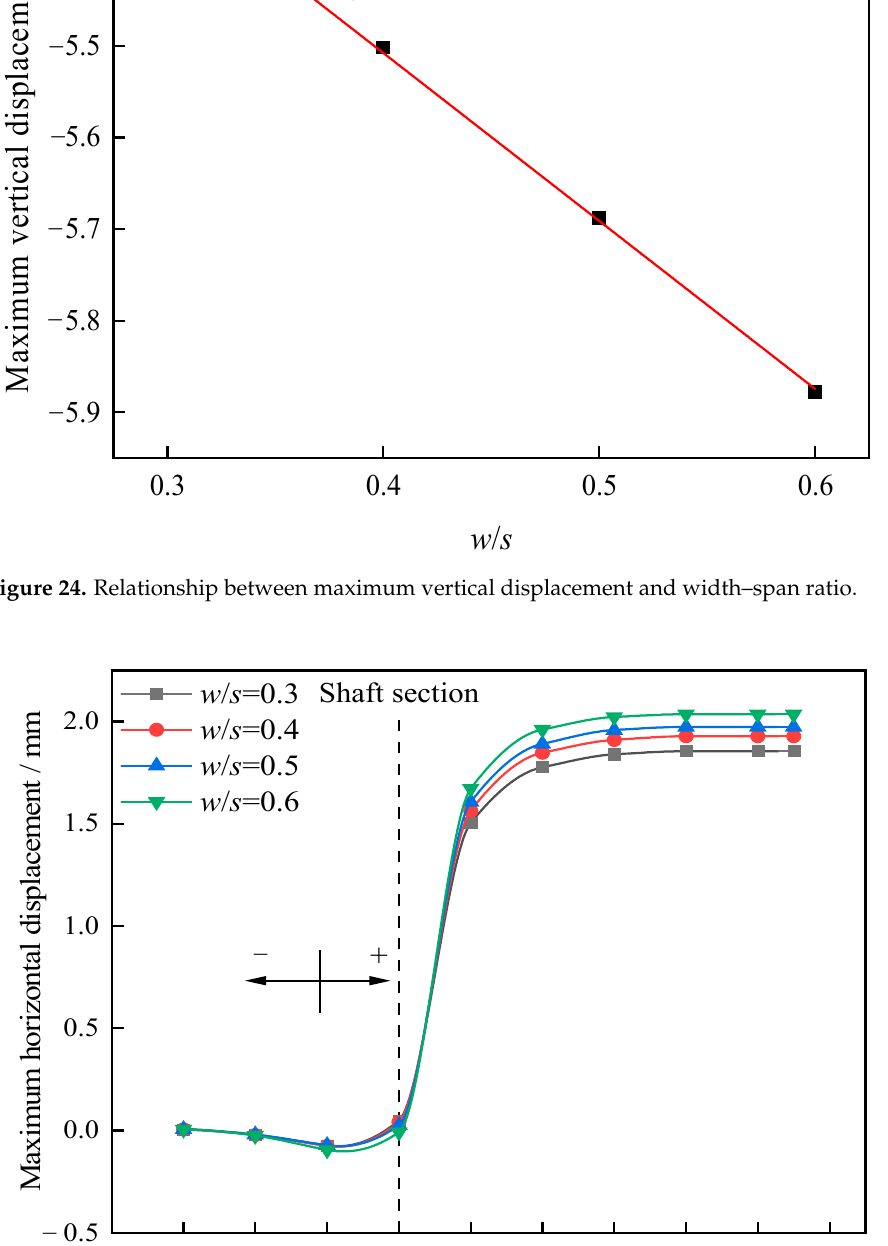
Figure 25. Horizontal displacement curve of the side wall.